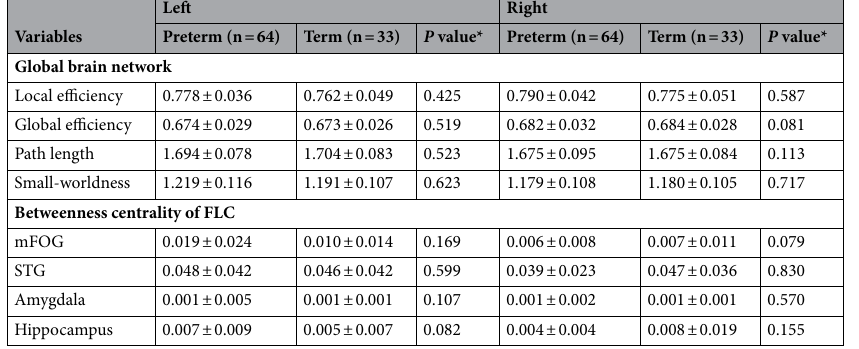
Table 2. Network measures of the left and right hemisphere in the preterm and term infants. Data are presented as the mean ± SD. FLC fronto-limbic circuit, mFOG medial fronto-orbital gyrus, STG superior temporal gyrus. *Adjusted for sex, age at MRI scan and bronchopulmonary dysplasia.